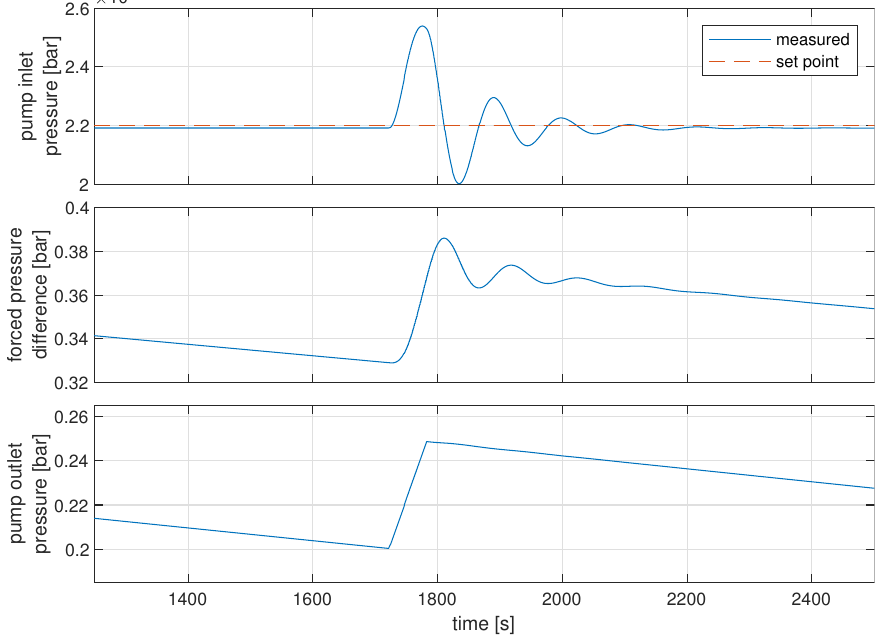
Figure 16. Pump inlet pressure (bar) ( top , blue solid line) and pump inlet pressure set point (bar) ( top , red dashed line); pressure difference generated by the pump (bar) ( middle ) with pump outlet pressure (bar). ( Bottom ) reference control